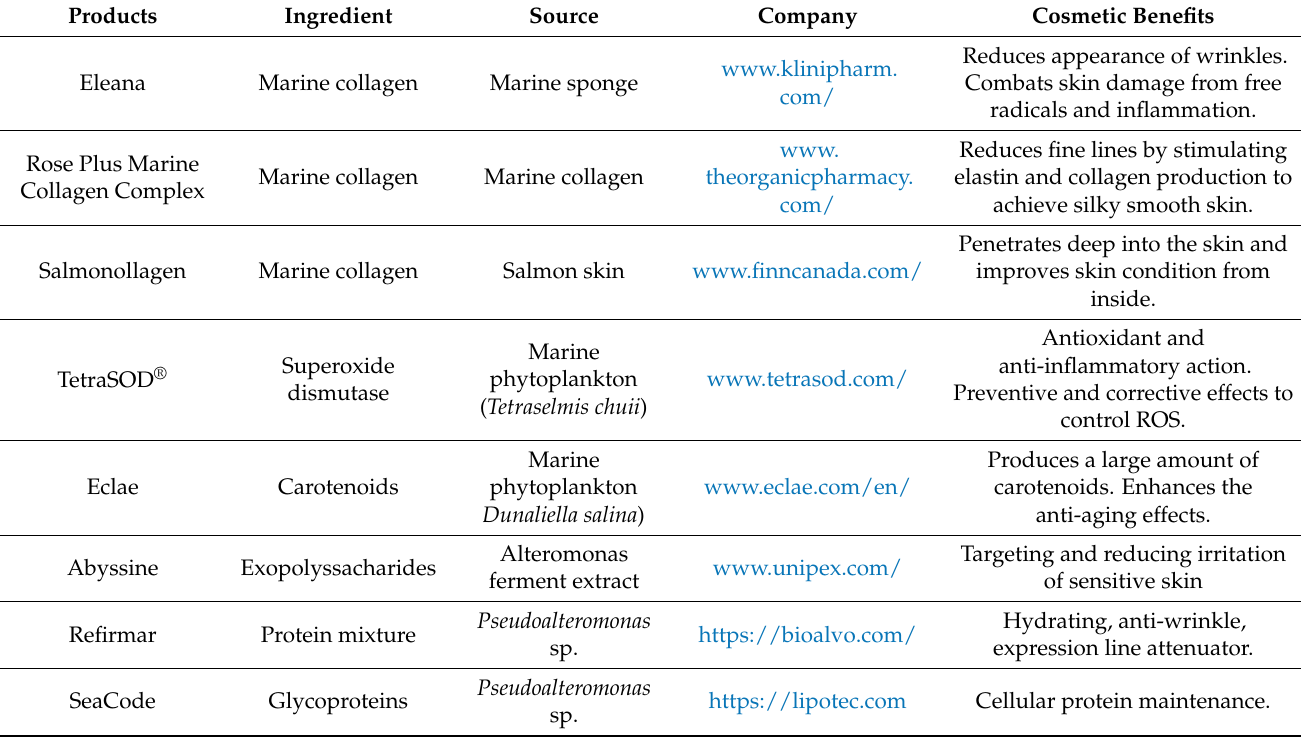
Table 1. Cosmetic companies that use marine cosmeceutical ingredients in their